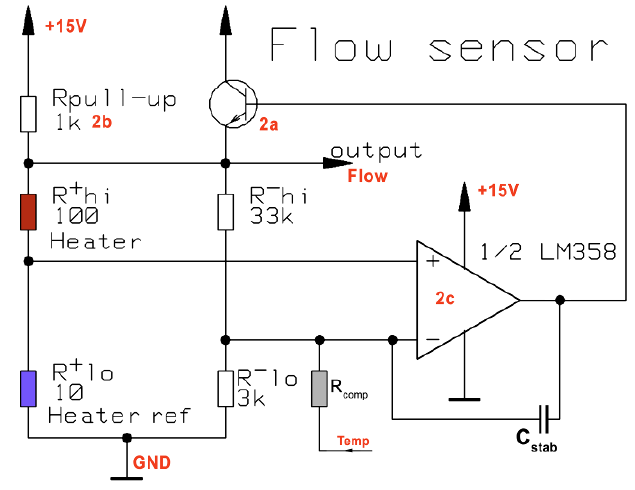
Figure 7. Simplified electrical schematic of the flow sensor section. It is basically a Wheatstone bridge with an amplifier, whose buffered output heats the measuring resistor to regulate its